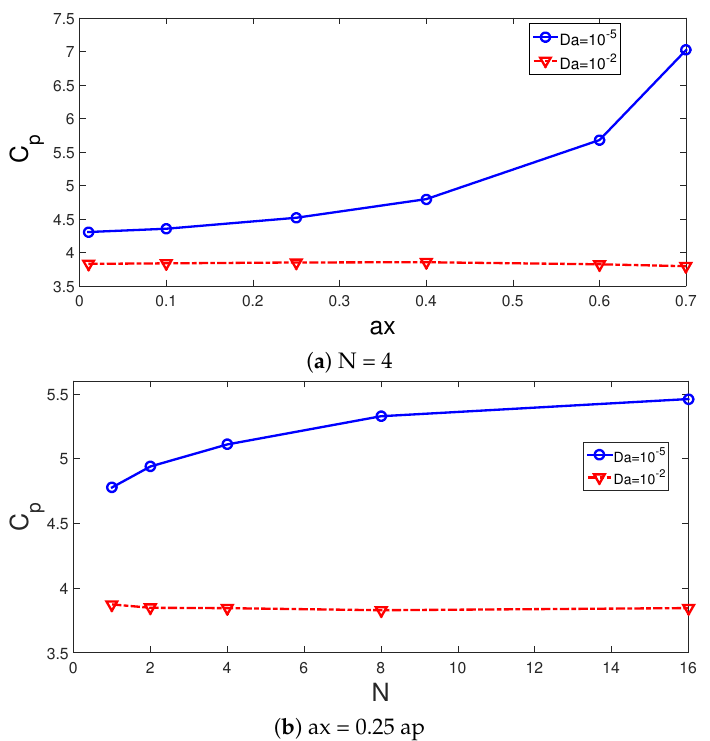
Figure 14. Pressure coefficient variations with different corrugation amplitude ( a ) and wave number ( b ) at two different PL permeabilities (Re = 250, Rew = 1000, Ha =